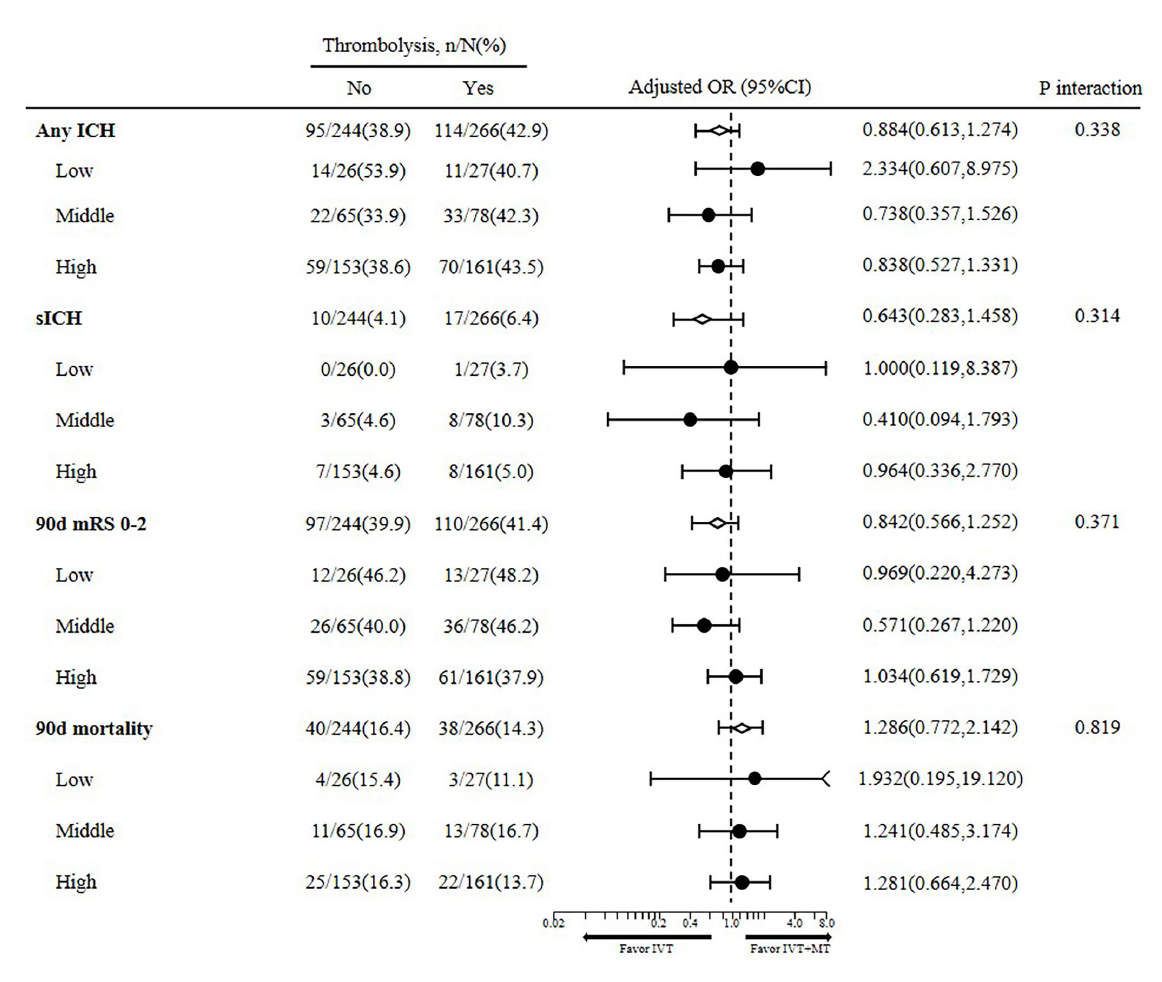
FIGURE1 Interaction between baseline blood pressure with intravenous alteplase on clinical